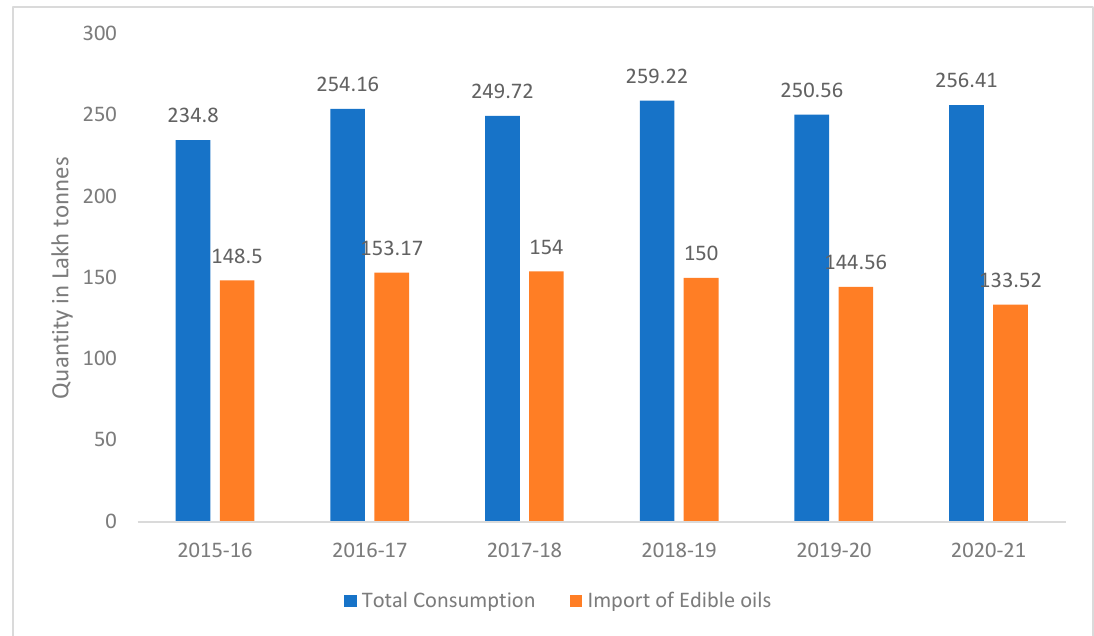
Figure 2. Total annual consumption and import of edible oil.